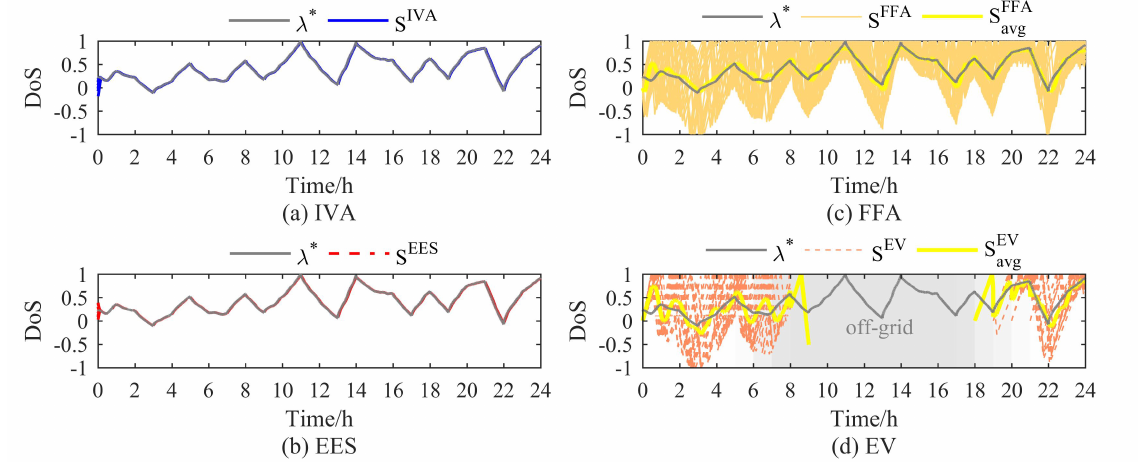
Figure 9. Performance of the DoS-equality control in Case 1.